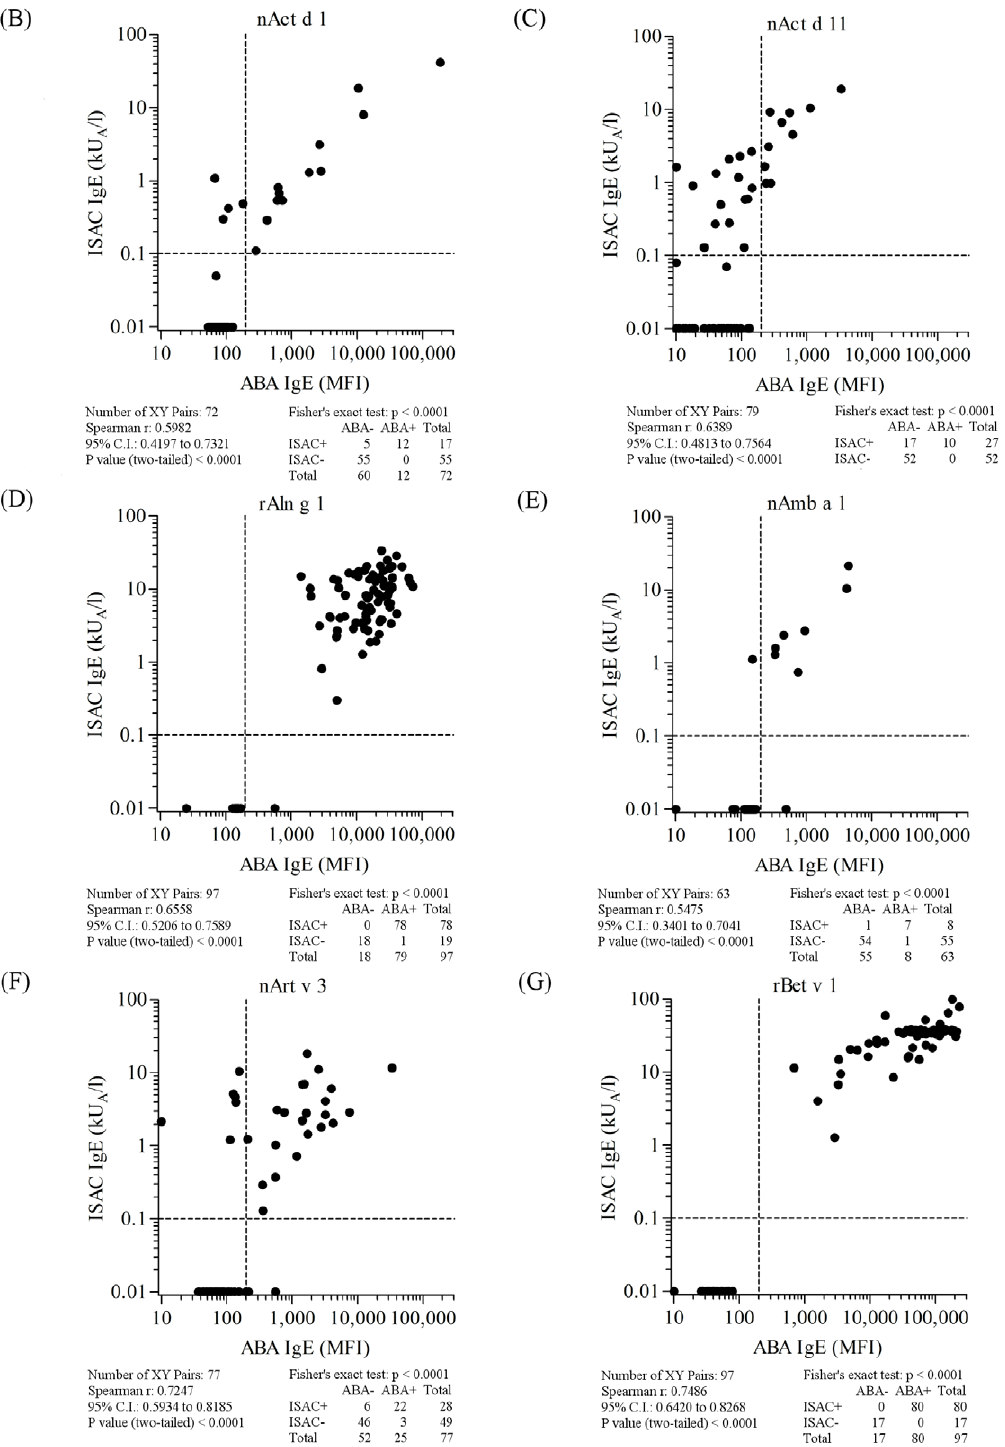
Figure 6. ABA versus ISAC correlation results on serum samples selected on the basis of the allergen specificities reported in each panel and listed in Table S1. Letter flags, namely B, C, D, E, F, G, in figure 6 indicate them as parts of the results shown also in figures 5, 7, and 8. Consecutive letters are used on purpose to recall result type continuity across the four figures. Allergen nature, being either natural or recombinant, matched for both tests. Vertical dashed lines represent the arbitrary ABA negative cut off value. Horizontal dashed lines mark the value range where ISAC IgE determinations are not always reproducible (unpublished data). For graphical visualization needs on log scales, zero value for ABA was set at 10 MFI on the X axis, and at 0.01 kU/l for ISAC value on the Y axis. The Spearman r correlation coefficient was calculated and the Fisher’s exact test was used for statistical purposes. Statistical results are reported below each graph.